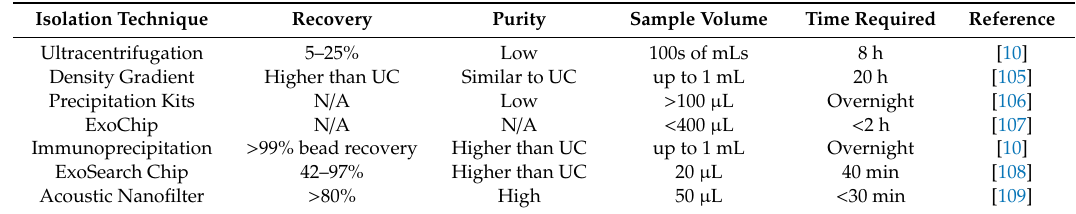
Table 1. Comparison of exosomal isolation techniques based on recovery, purity, required sample volume, and time required for